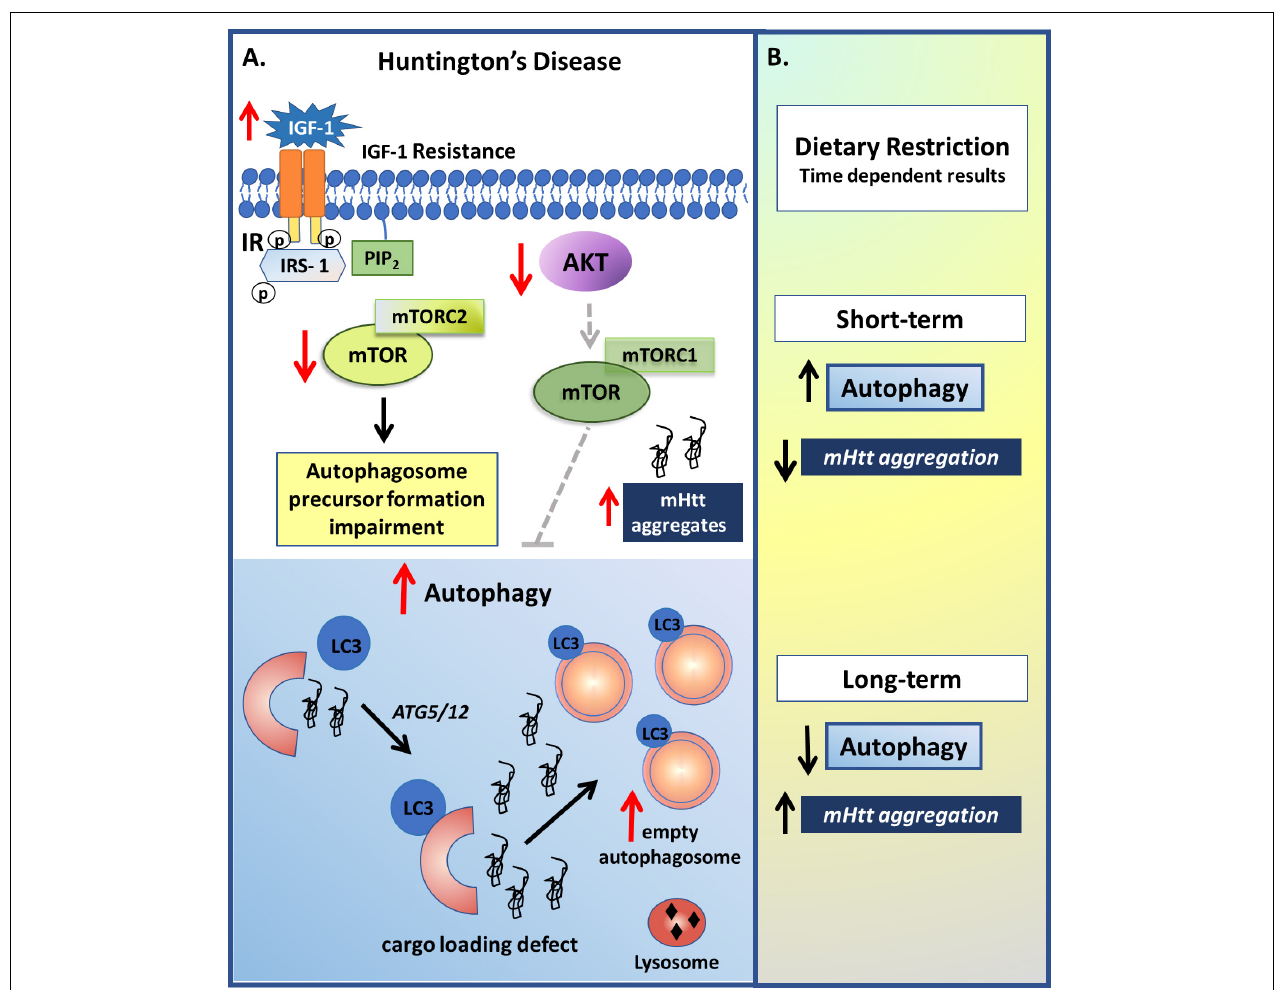
FIGURE 5 | Insulin and autophagy signaling modulation in Huntington’s disease (HD). (A) Although the IGF-1 role on HD still seems paradoxical, it is clear that it develops an important role in this pathology. As observed in some studies, HD patients present higher basal plasma levels of IGF-1, which may be related with an IGF-1 resistance condition and a reduction in the insulin pathway. The reduction in IR activity results in reduced mTORC2 and AKT-mTORC1 activities, which leads to, respectively, a reduction in autophagosome precursor formation and an increase in the autophagy process, which may be related with the upregulation of autophagosomes with deficits in cargo recognition. However, long term IR down regulation, due to for example, receptor depletion or long term IR inhibition, results in reduced autophagy, which may be due to a lack of essential autophagosome precursor formation, and increased mHtt aggregates. (B) Non-pharmacological approaches such as dietary restriction also demonstrated to have a dual effect depending on the time. Short-term fasting resulted in increased autophagy and reduction on mHtt aggregation, while long-term serum deprivation resulted in reduced autophagosome formation.